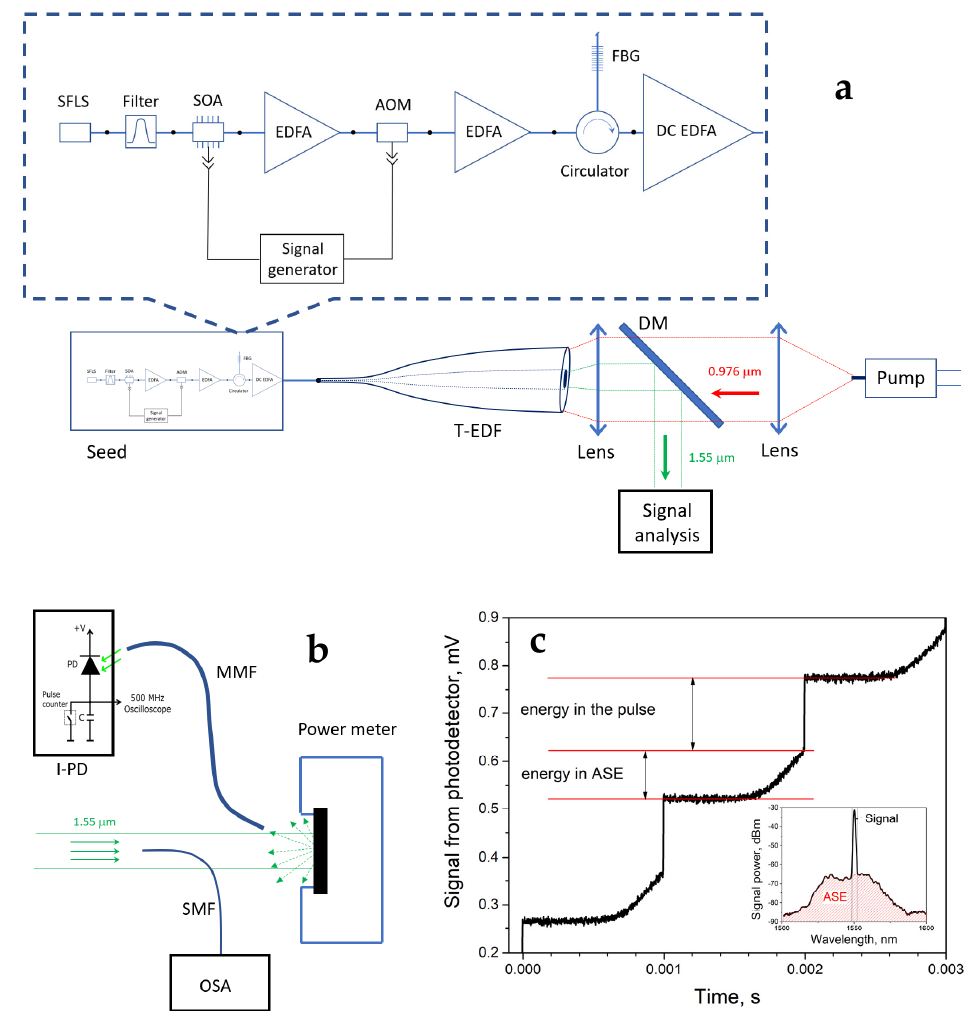
Figure 2. ( a ): Scheme of the laser set-up; ( b ): Signal analysis scheme; ( c ): Signal measured by I-PD; inset to ( c ): spectrum measured by OSA. Designations: SFLS—polarized super luminescent fiber laser source, Filter—fiber filter with FWHM of ~1 nm, SOA—semiconductor optical amplifier, EDFA—core-pumped Er-doped fiber amplifier, DC EDFA—cladding-pumped Er-doped fiber amplifier, AOM—acousto-optical modulator with fiber pigtails, FBG—fiber Bragg grating, T-EDF—tapered Er-doped fiber, DM—dichroic mirror, I-PD—integrating photodetector (see [1] for details), MMF—multi-mode fiber with core diameter ~360 μ m, SMF—single-mode fiber (SMF28), OSA—optical spectrum analyzer.